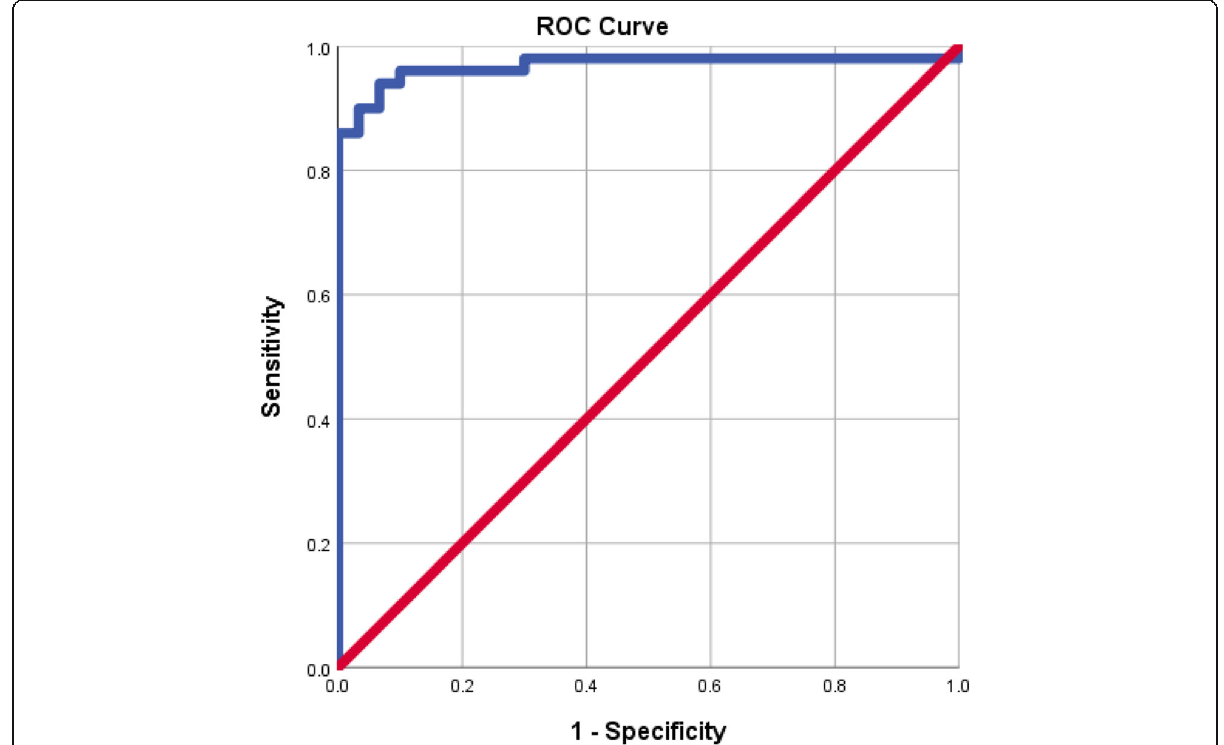
Fig. 3 The results of ROC curve analysis of DKK-1 in the studied SLE and normal population